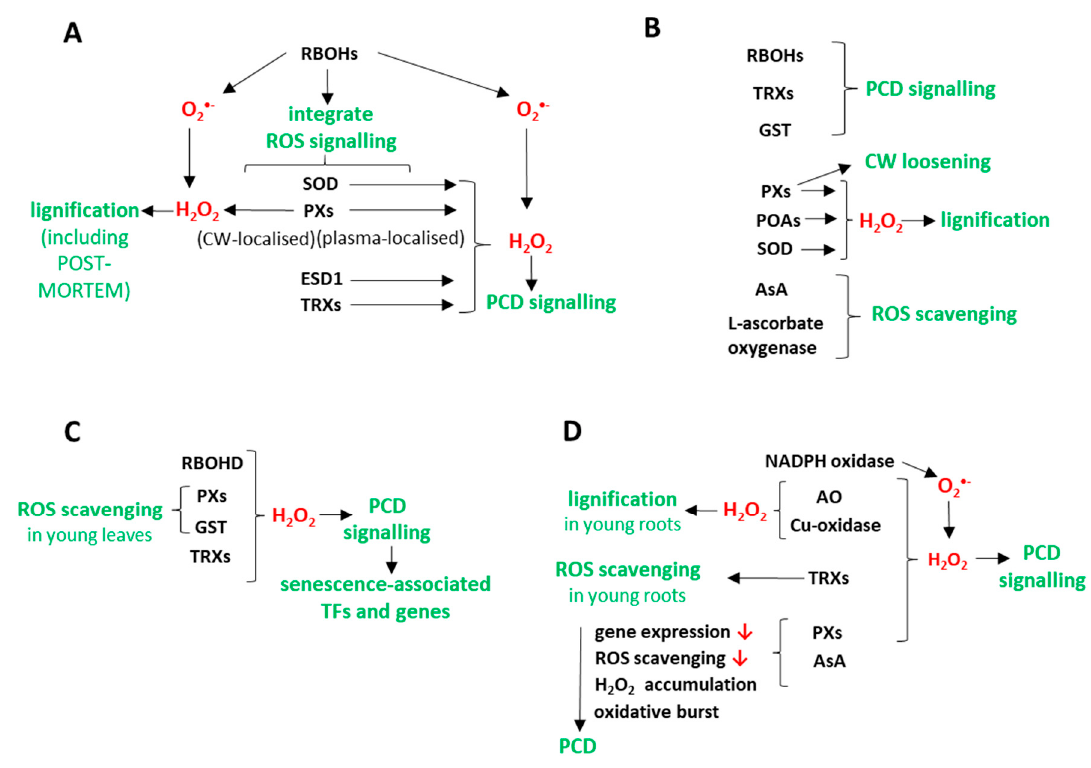
Figure 7. Simplified models describing the major changes in ROS metabolism in stems ( A ) and pioneer roots ( B ) during their primary and secondary growth, and in senescing leaves ( C ) and fine roots ( D ) of Populus trichocarpa . The downward red arrows show decreased features. (Abbreviations: